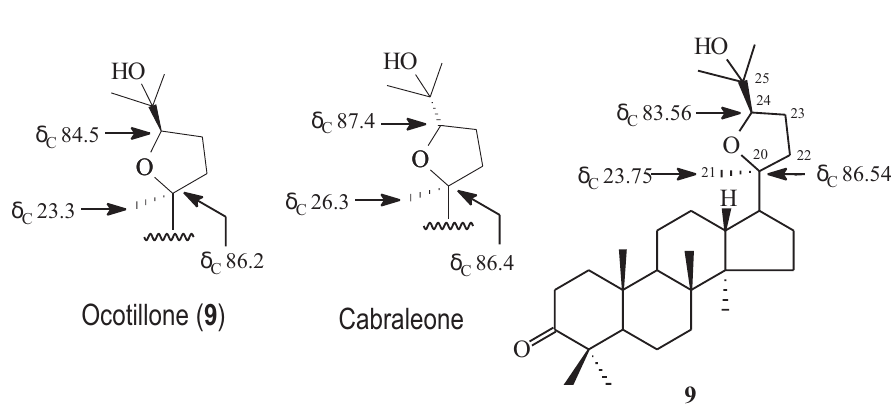
Fig. 2 – Comparison of the 13 C chemical shifts of the CH-24 methine carbon and CH 3 -21 methyl of 9 with values described in the literature (Tanaka and Yahara 1978) for ocotilone ( 9 ) and cabraleone (24-epiocotilone).